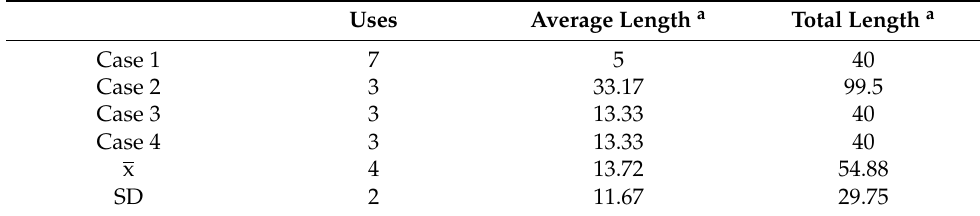
Table 4. Interactions with Otteroo from Activity